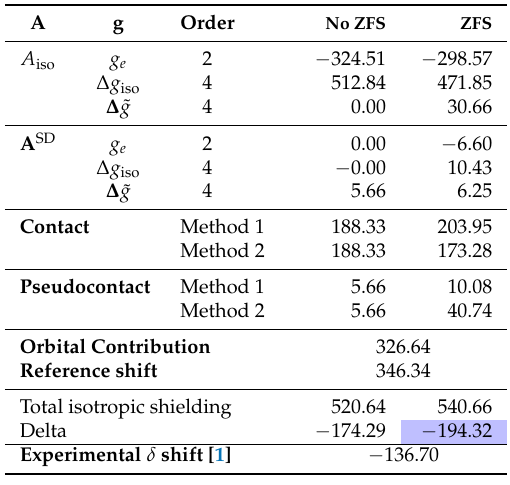
Table 13. Calculated 29 Si pNMR shifts of U(C 5 Me 5 · Et)(1,4-C 8 H 6 (Si i Pr) in ppm at 298 K. The final, ZFS corrected, computational values are highlighted.